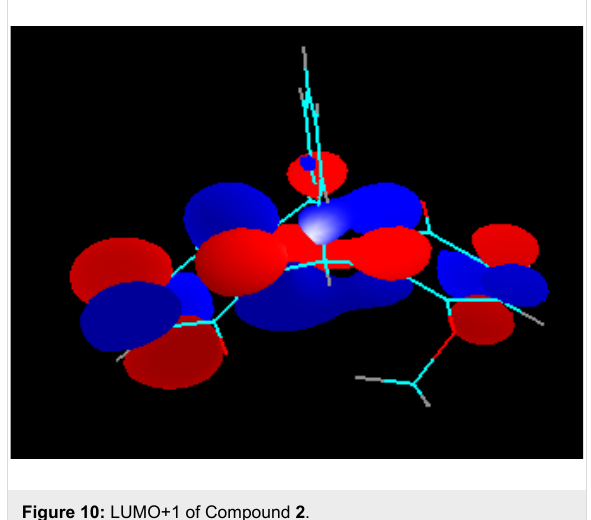
In the dimethoxy-derivative 2 , the LUMO has some contribu- tion from the bridgehead σ-bonds of the non-quinone part of the molecule, whereas the LUMO+1 orbital is heavily weighted on the substituted benzene ring. This phenomenon is general for the whole series of substituted triptycene-quinones 1–3 and 5